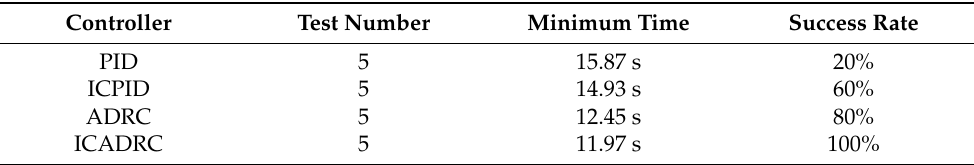
Table 4. Landing results on the sea under different controllers.